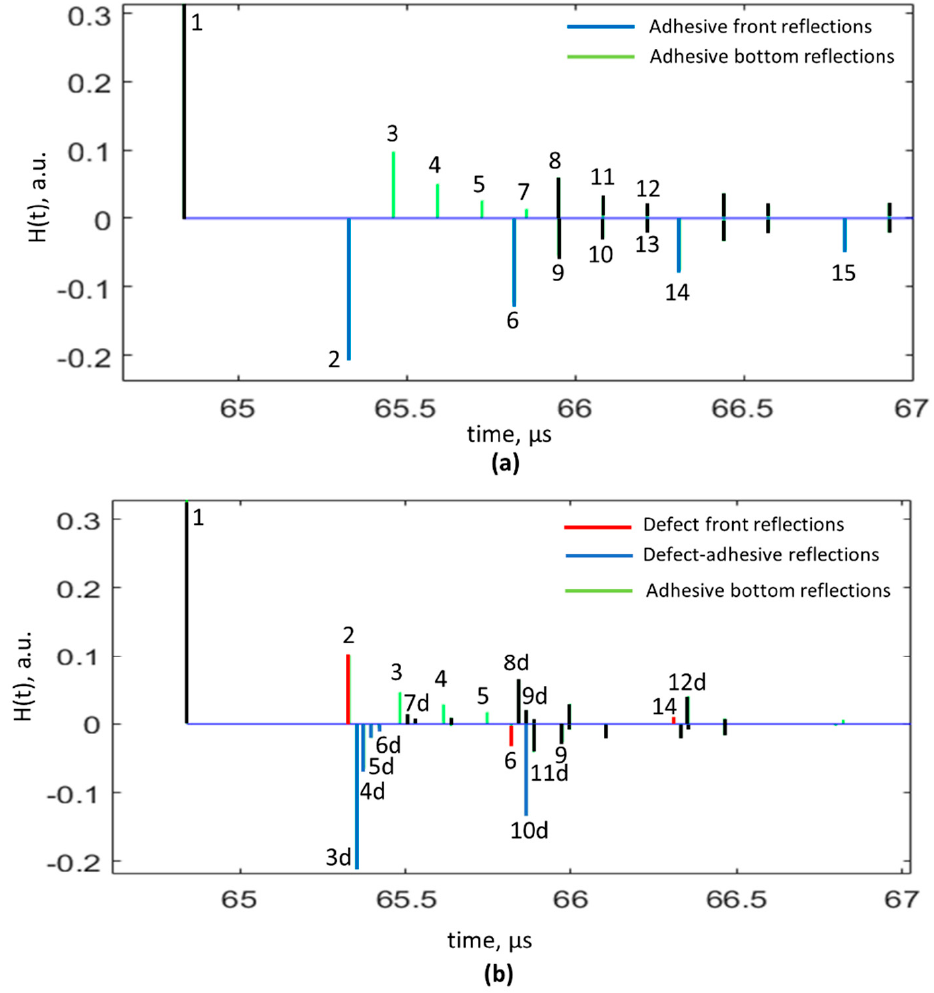
Table 1. Characteristics of the sample materials and medium.